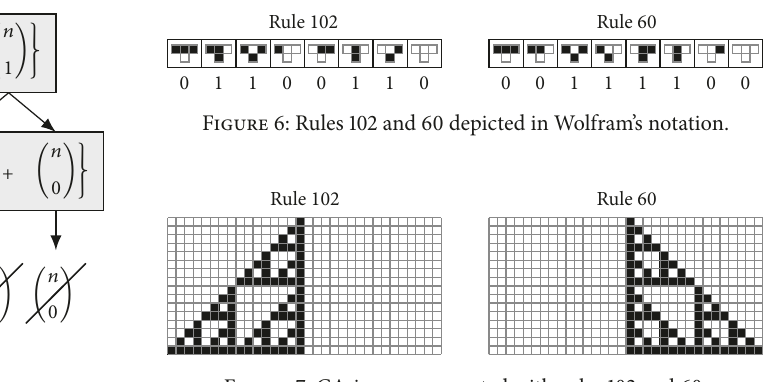
Figure 7: CA-images generated with rules 102 and 60.